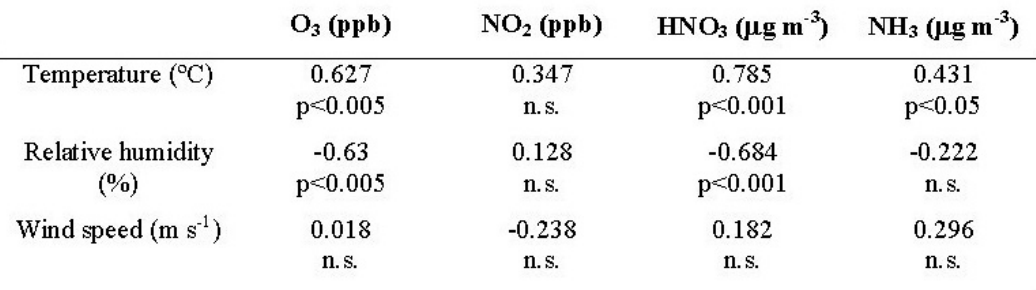
Correlation Coefficients between Meteorological Variables and Air Pollutants (n = 25 – 26)*